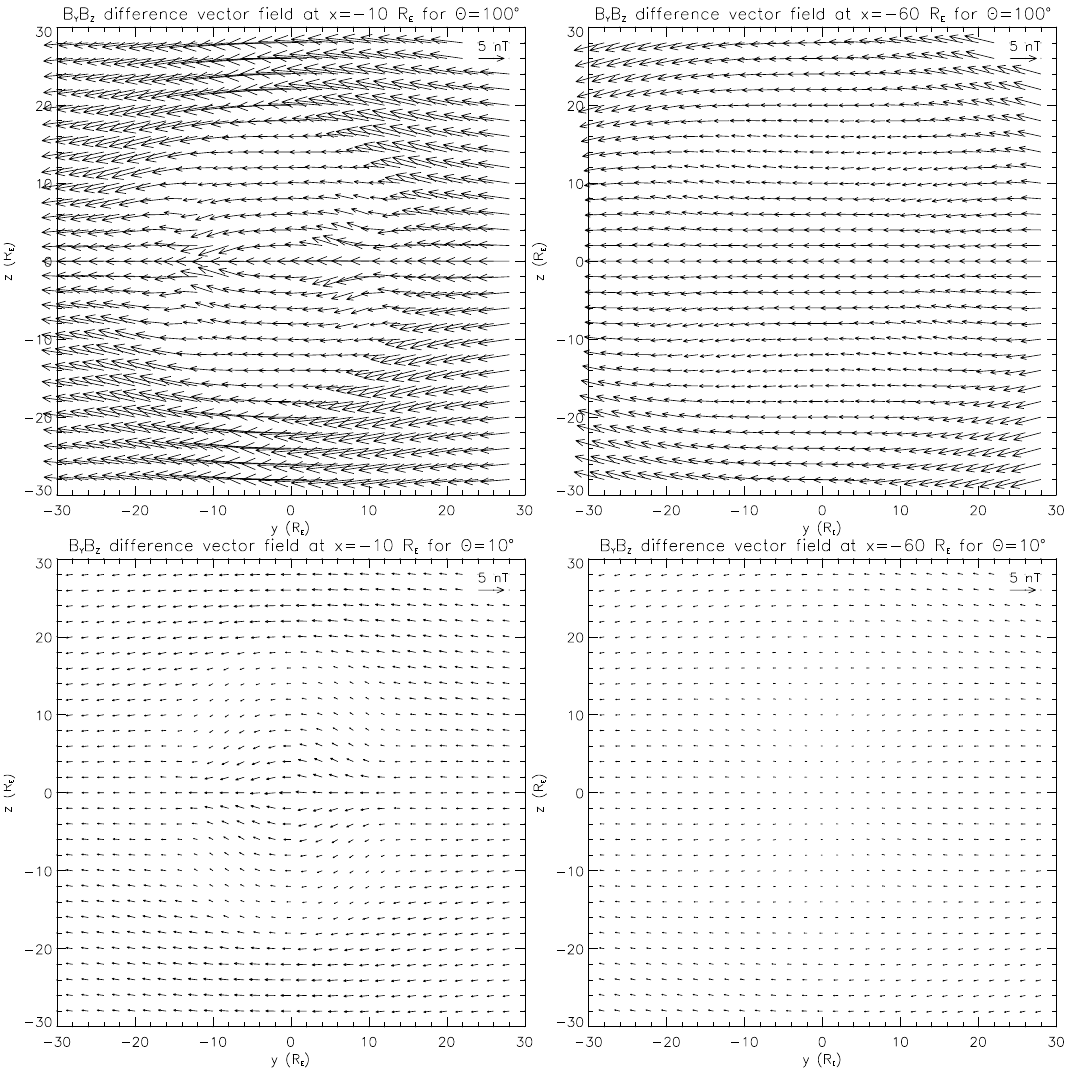
Fig. 3. The additional magnetic field that occurs in the tail during nonzero IMF B y . In the Figure, two different tail cross sections for the constant IMF runs 1a (up) and 1d (down) are shown. The plots are produced by mirroring the B y B z vector components of the corresponding tail cross section along the z -axis, subtracting the mirror vectors from the original vectors and dividing the results by